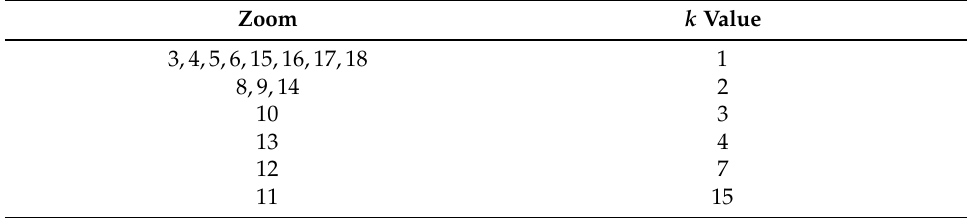
Figure 7. Numbers and average values of POIs of s 1 – s 5 in different scales. Table 2. k value allocation